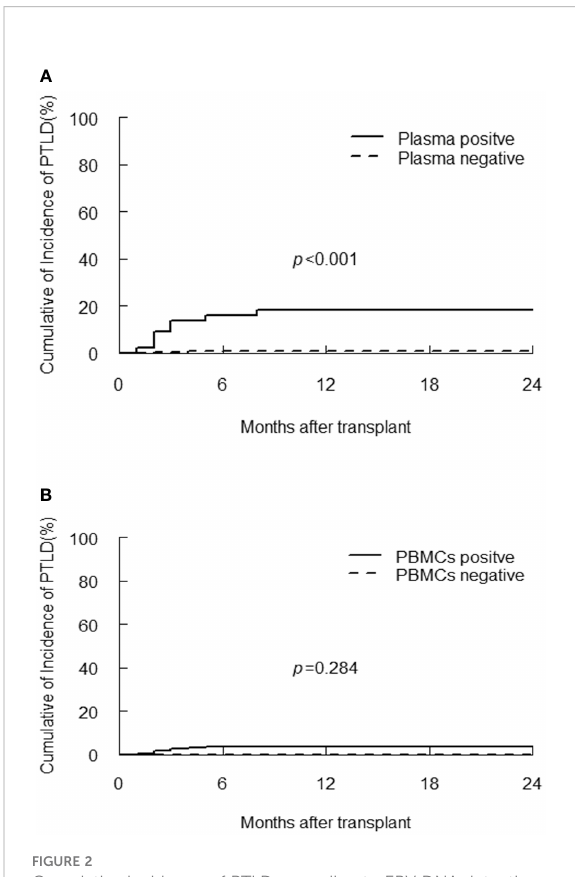
FIGURE 2 Cumulative incidence of PTLD according to EBV DNA detection in plasma (A) and PBMCs (B) .